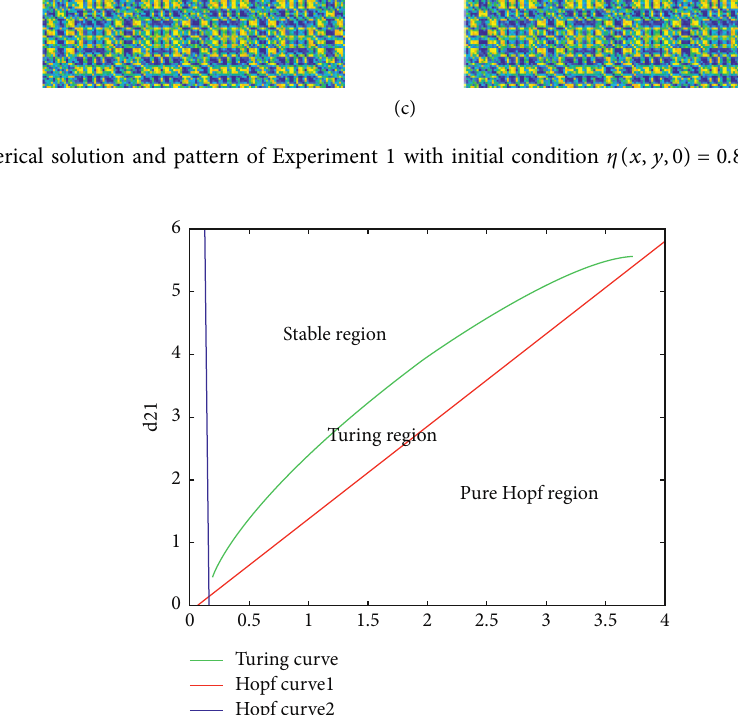
− a space of Experiment 2 with c � 0 . 78 , b � 0 . 78 , d 21